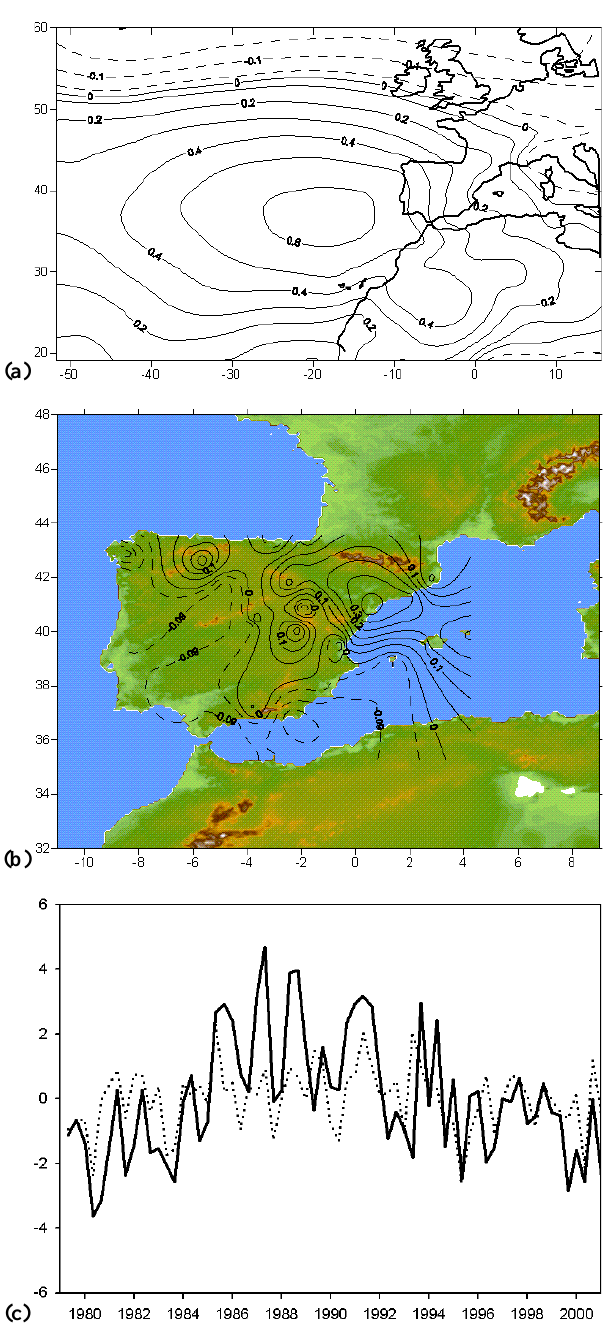
Fig. 4. Same as Fig. 2 except for the SVD2.